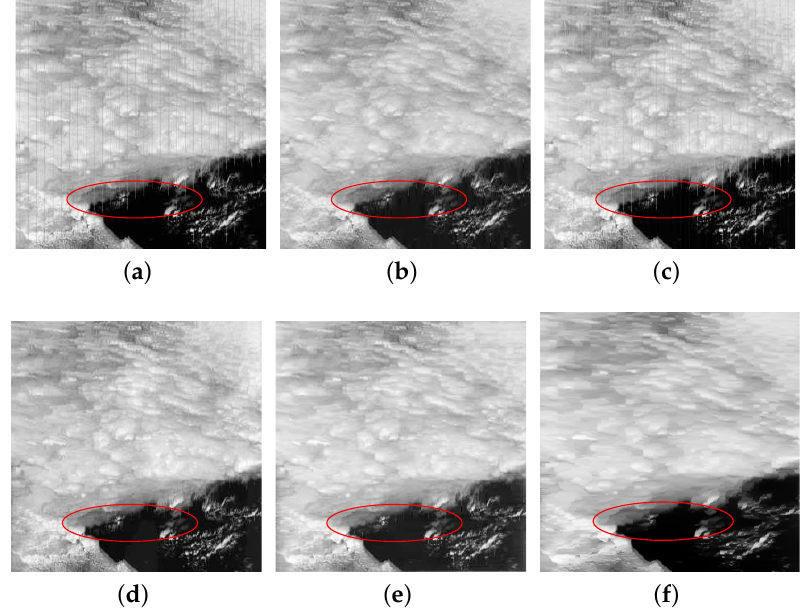
Figure 12. Destriping results of periodic stripes in Aqua MODIS band 5. ( a ) Original image; ( b ) WAFT;